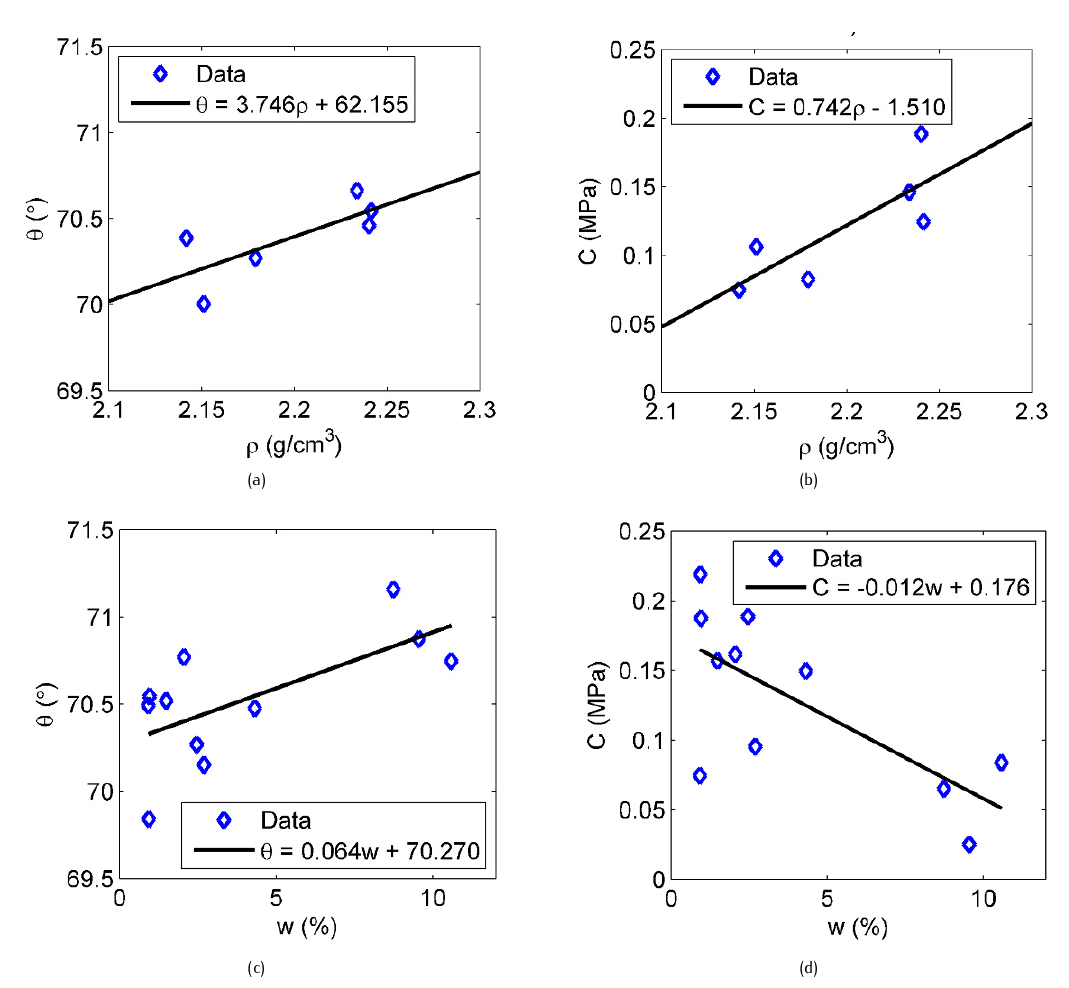
Figure 8. Experimental investigation on the yield function friction angle ( θ ) and cohesion ( C ). a) and b) shows density ( ρ ) dependence for dry samples, c) and d) shows moisture ( w ) dependence for wet and dry samples.